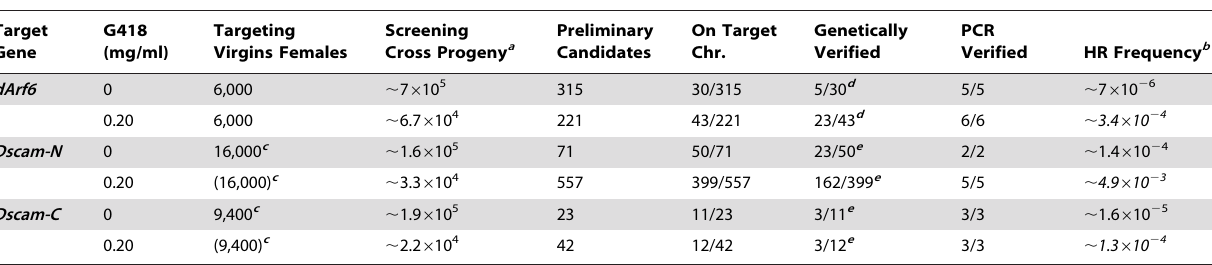
Table 2. Generation of founder knock-out lines by ends-out targeting.